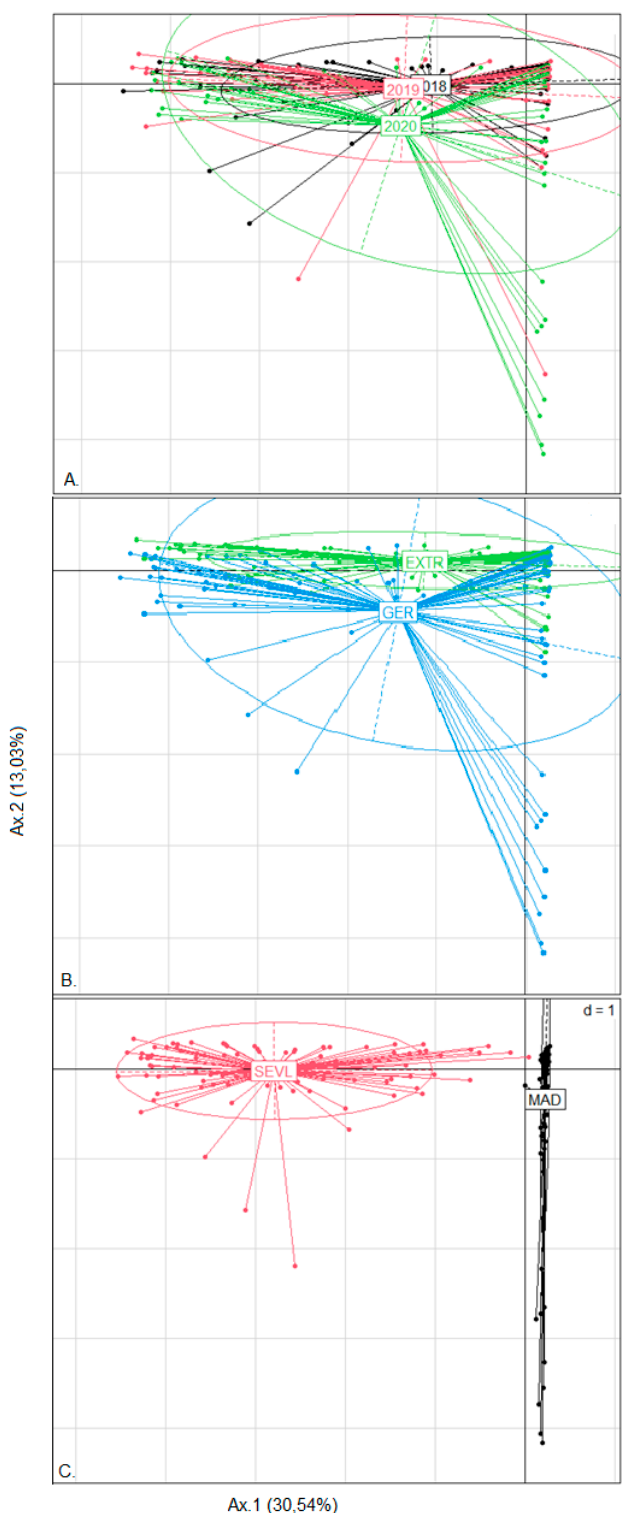
Figure 2. Correspondence analysis (CA) represented in ordiplots A, B and C, factorial maps with representation of point classes, arranged by groups of individuals s.class (ade4) function. Ordiplot ( A ) “year” factor used to draw the groups on the factor map. Ordiplot ( B ) “method” factor used to draw the groups on the factor map. Ordiplot ( C ) “location” factor used to draw the groups on the factor map. A x.1 (30.54%): Projected inertia Dimension 1; Ax.2 (13.03%): Projected inertia Dimension